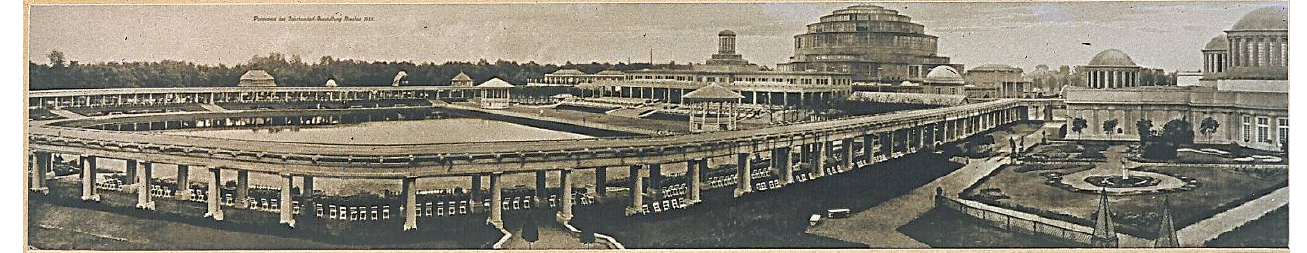
Figure 6. Pergola built in 1912–1913 and designed by Hans Poelzig, Breslau Exhibition Grounds (Museum of Architecture in Wrocław).